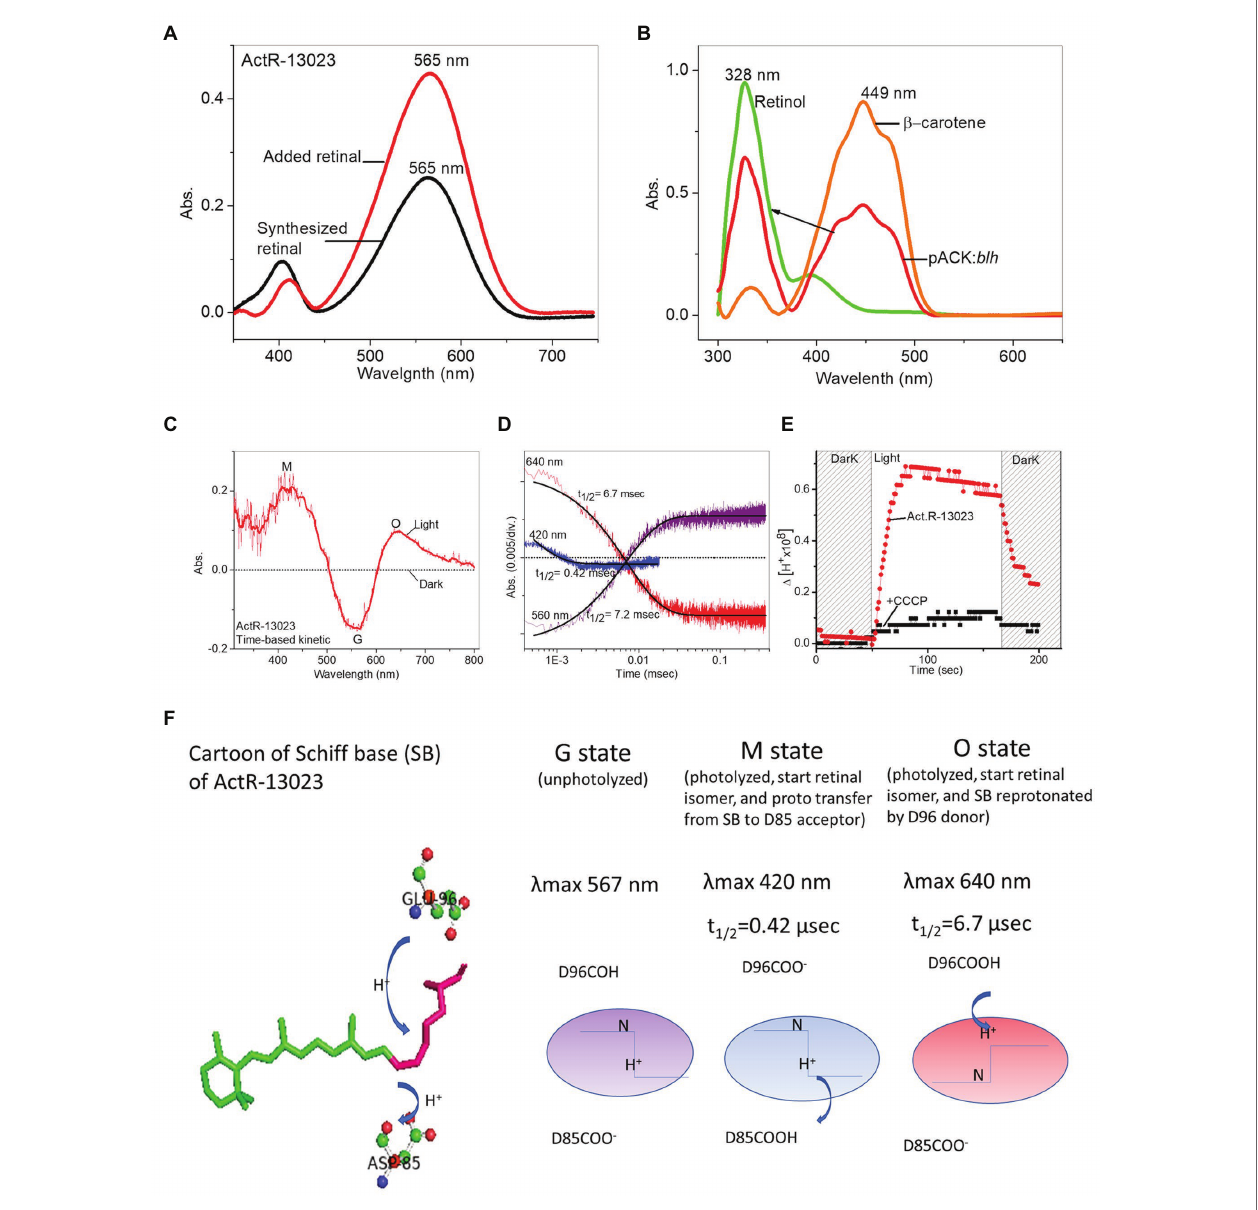
FIGURE 3 | Characterization of heterologously expressed ActR-13023. (A) Expression with additional all- trans -retinal (red) and bio-synthesized retinal (black). (B) Retinol conversion from β -carotene using the enzyme encoded by the C. aquiluna blh gene. (C) A light-induced differential spectrum of purified ActR-13023. (D) Flash-induced transient absorbance changes during the photocycle. (E) Proton pumping activity of heterologously expressed ActR-13023. (F) Illustration of naturally functional ActR-13023 as a light-driven outward proton